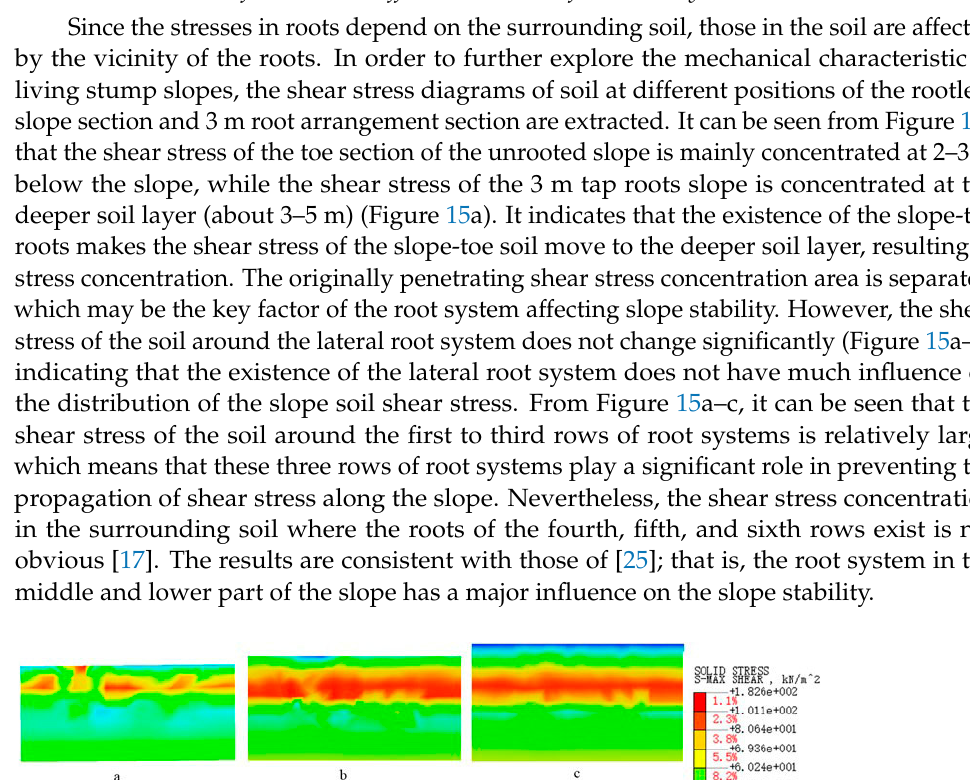
Figure 15. The shear stress of the soil at the 3 m root slope section: ( a ) The slope toe, ( b ) The second row, ( c ) The third row, ( d ) The fourth row, ( e ) The fifth row, ( f ) The sixth row. 4.3. Root Mechanical Characteristics A significant result of our research is related to the mechanical characteristics of roots. Embedded beam elements were used to simulate the root system. Due to the limitations of embedded beam elements, root slippage caused by large deformations of the root-soil system might not occur. Therefore, potential errors could arise due to the influence of the root-soil interface. Understanding the latest development in root-soil interactions could simulate root-soil interactions more accurately by incorporating friction laws of root-soil interaction [40–42]. The laws of friction are needed to calculate simple root-soil complexes. Due to the complexity of the model, it is difficult to achieve it in our research. Since the embedded element method turned out to be a good choice in accuracy [30], the stress state of the root system in the slope soil was well simulated, which enabled us to use the model to analyze the mechanical characteristics of different 3D root structures in the soil. The results showed that the thickness, length, and position of the root may strongly affect its force on the slope and its influence on the slope stability. Compared with the root system in the upper part of the slope, the root system stress in the middle and lower parts of the slope is larger, contributing more to the anchorage of the soil [25]. No. 1 lateral root is mainly subjected to tensile stress, while the No. 4 lateral root is mainly subjected to compressive stress, which may be due to the symmetrical growth of the roots on both sides of the slope toe, and the No. 1 lateral root played an anchoring role, while the No. 4 lateral root did not. Additionally, the three rows of tap roots in the middle and lower part of the slope are also subject to greater bending mo-